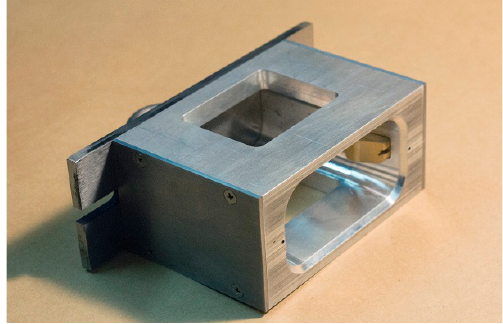
Figure 8. The target cassette.